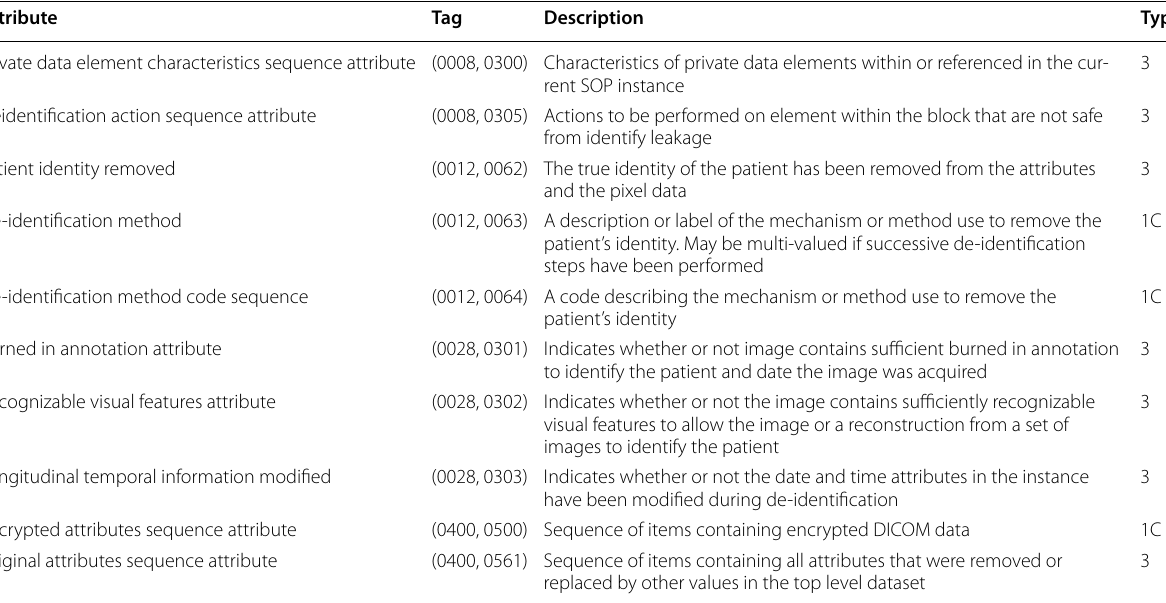
Type 3: optional; Type 1C: